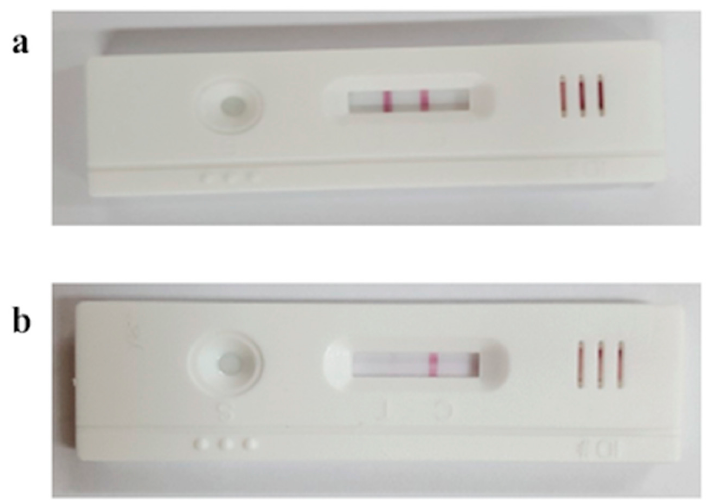
Figure 4. Estrous discrimination using bovine heat detection kit during estrus ( a , Group 2) and non-estrus ( b , Group 3). non-estrus ( b , Group